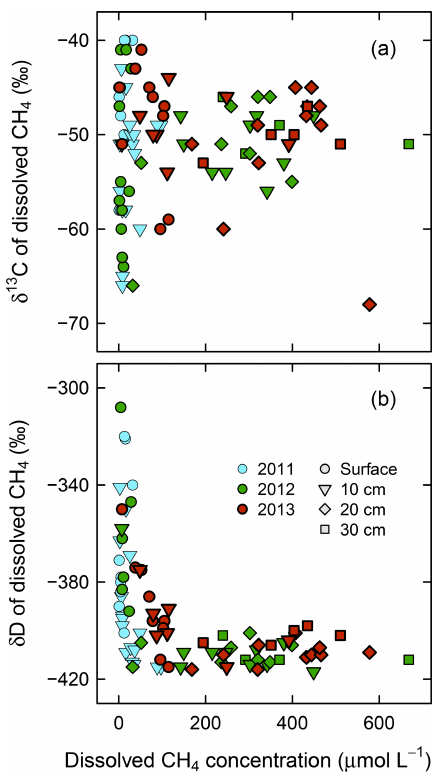
Figure 6. In situ (a) δ 13 C and (b) δ D versus concentration of dis- solved CH 4 at four depths (surface water, 10, 20, and 30cm) in wet areas from 2011 to 2013.